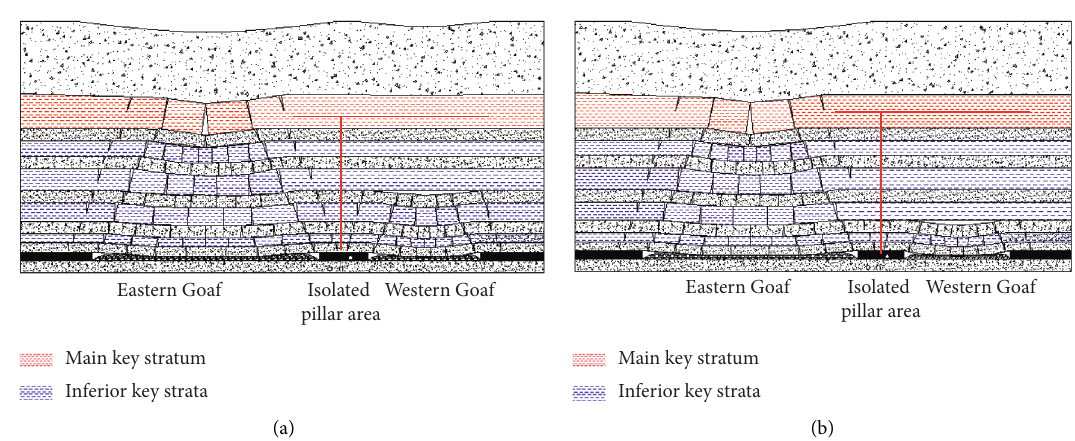
Figure 6: T-type overlying structure of isolated pillar in central mining district: (a) I-I section overburden structure; (b) III-III section overburden structure.